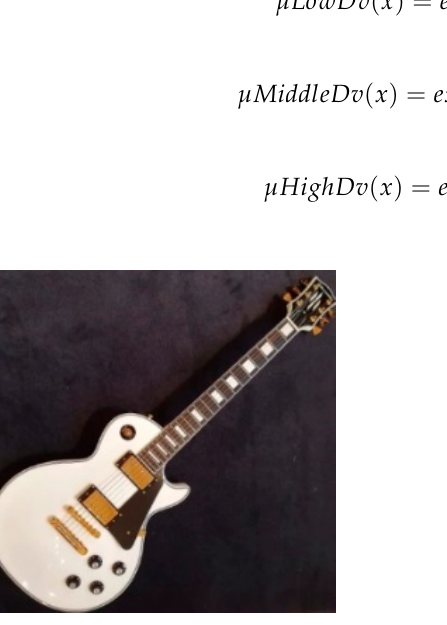
Figure 5. Input guitar image.